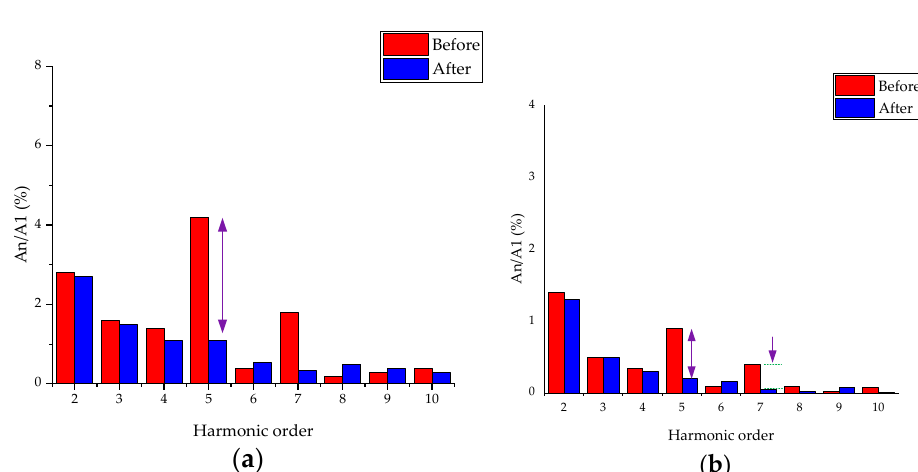
Figure 15. The notch of the rotor pole [55].